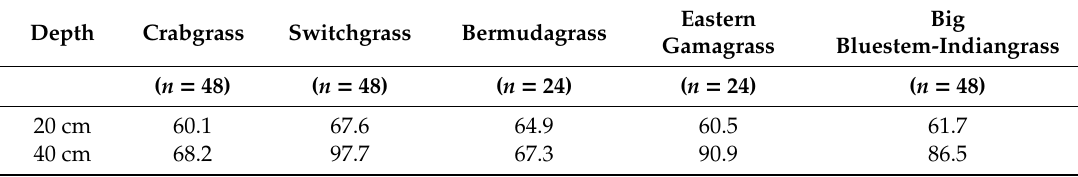
Table 5. Soil tension (kPa) at two depths (20 and 40 cm) for experimental paddocks by species,